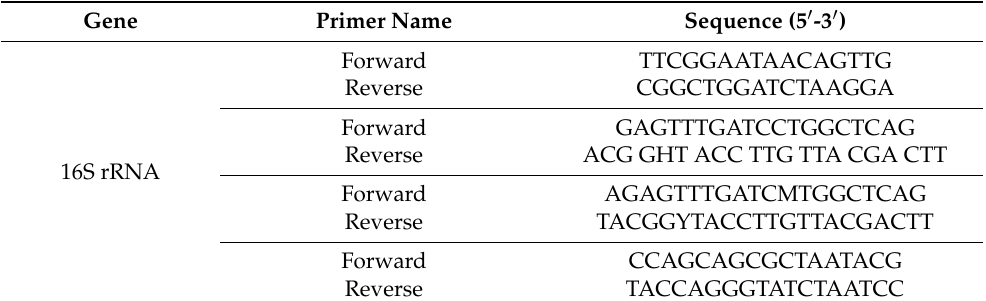
Table 1. Sequences of the forward (F) and reverse (R) primers, for 16S rRNA gene. Sequences were retrieved from